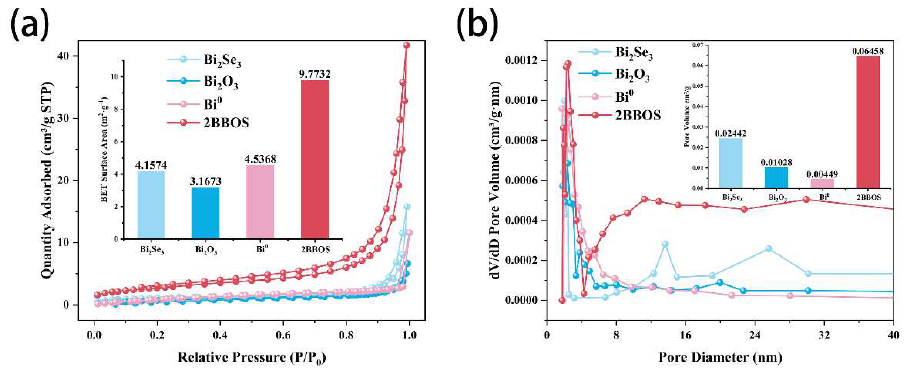
Figure 6. ( a ) BET N 2 adsorption-desorption isotherms and ( b ) pore size distribution of Bi 2 Se 3 , Bi 2 O 3 , Bi 0 and 2BBOS.